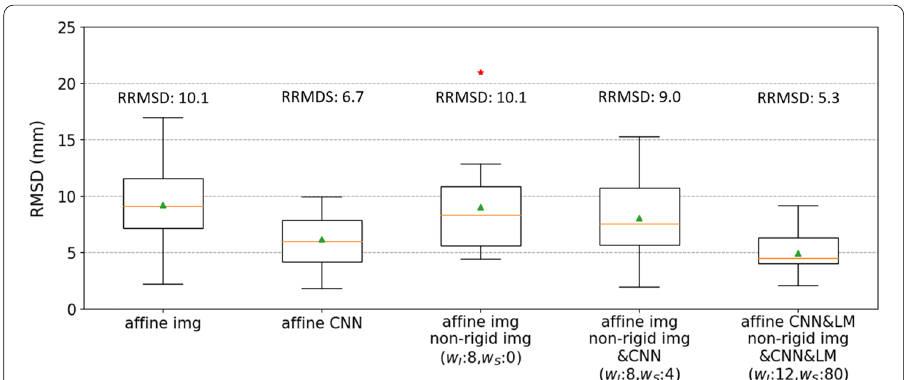
Fig. 7 RMSDs and RRMSDs of the test datasets (12 floating MR images) for comparison of image-based, CNN-guided, and CNN&LM-guided MR to CT